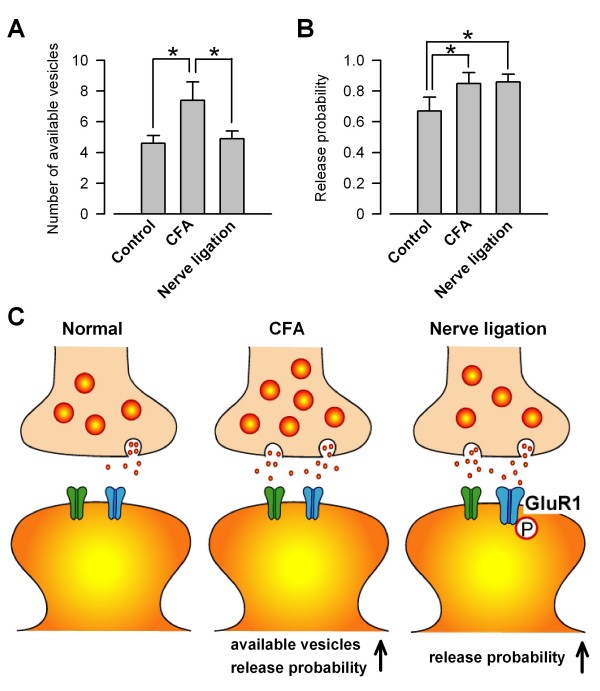
Number of available vesicles and release probability after peripheral inflammation and nerve ligation. A and B, Number of available vesicles (A) and release probability (B) in control mice (n = 12), mice following CFA injection (n = 8), and mice with nerve ligation (n = 9). *p < 0.05. C, A model for enhanced quantal release in ACC synapses with chronic pain. In mice following CFA injection, both probability of transmitter release and number of available vesicles are increased in ACC synapses. In mice with nerve ligation, only probability of neurotransmitter release but not number of available vesicles increased in ACC synapses. Upregulated phosphorylation of GluR1 contributes to an increase of postsynaptic responsiveness in mice with nerve ligation.